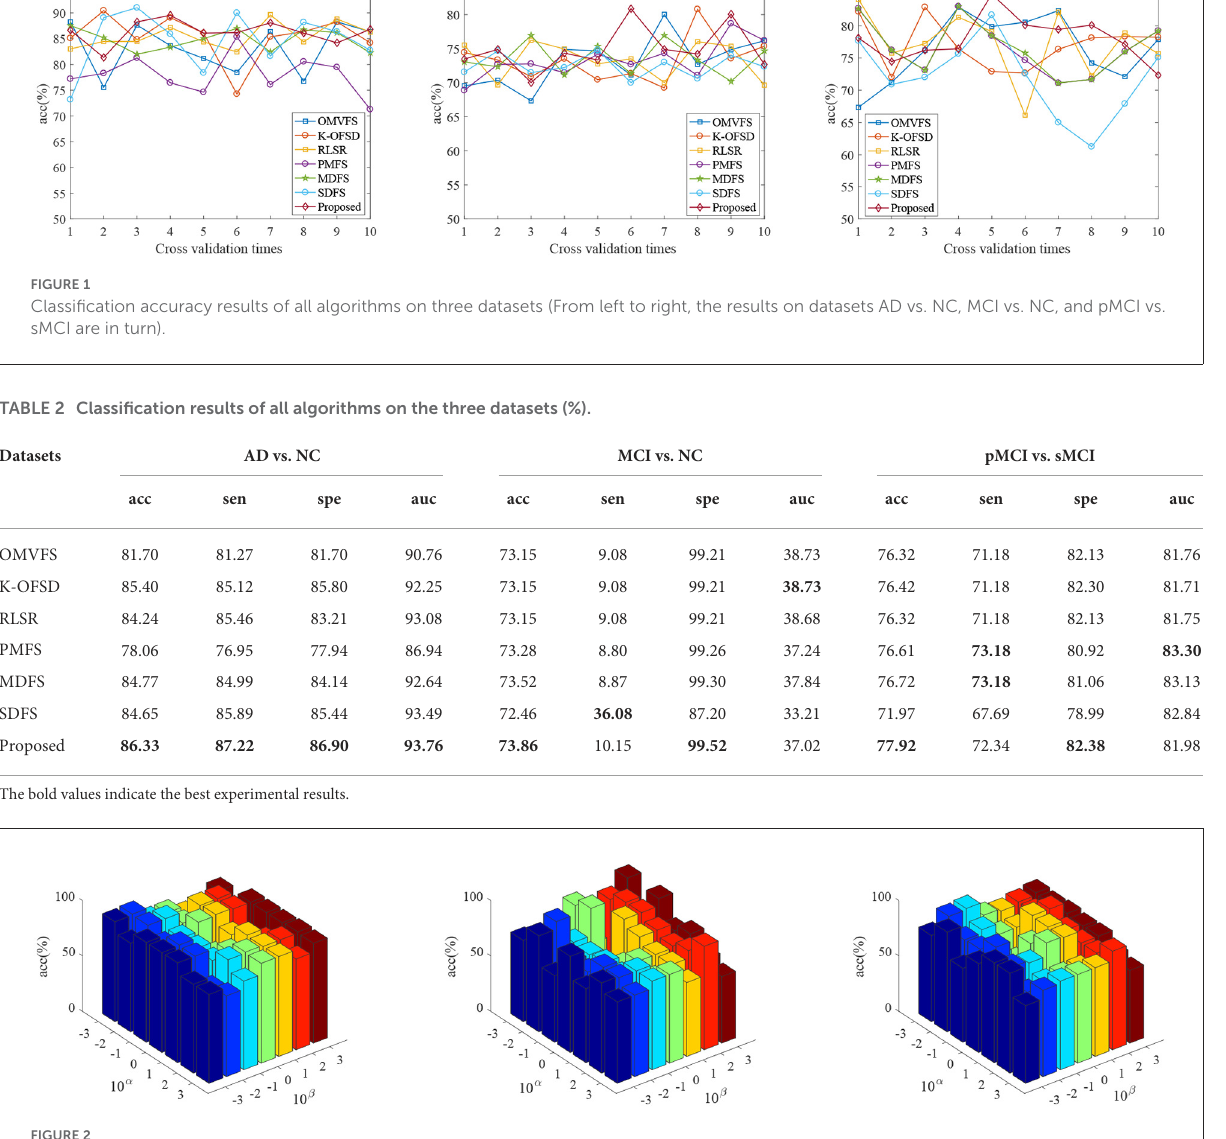
FIGURE2 The classification accuracy of the proposed algorithm varies with different parameter values. (From left to right, the results on datasets AD vs. NC, MCI vs. NC, and pMCI vs. sMCI are in